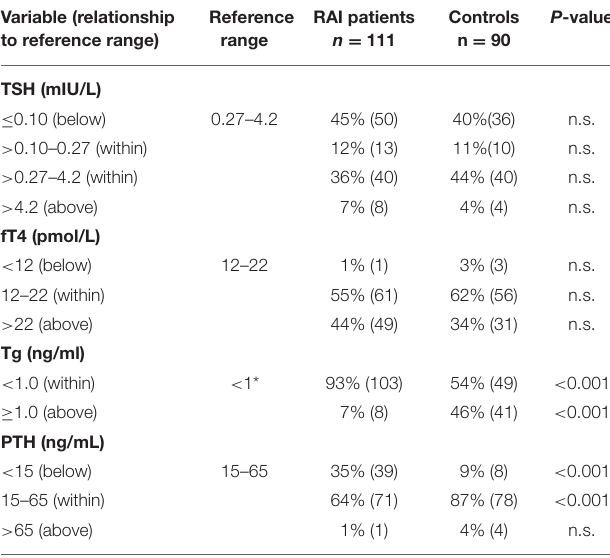
TABLE 2 | Current biochemical findings by category, % ( n